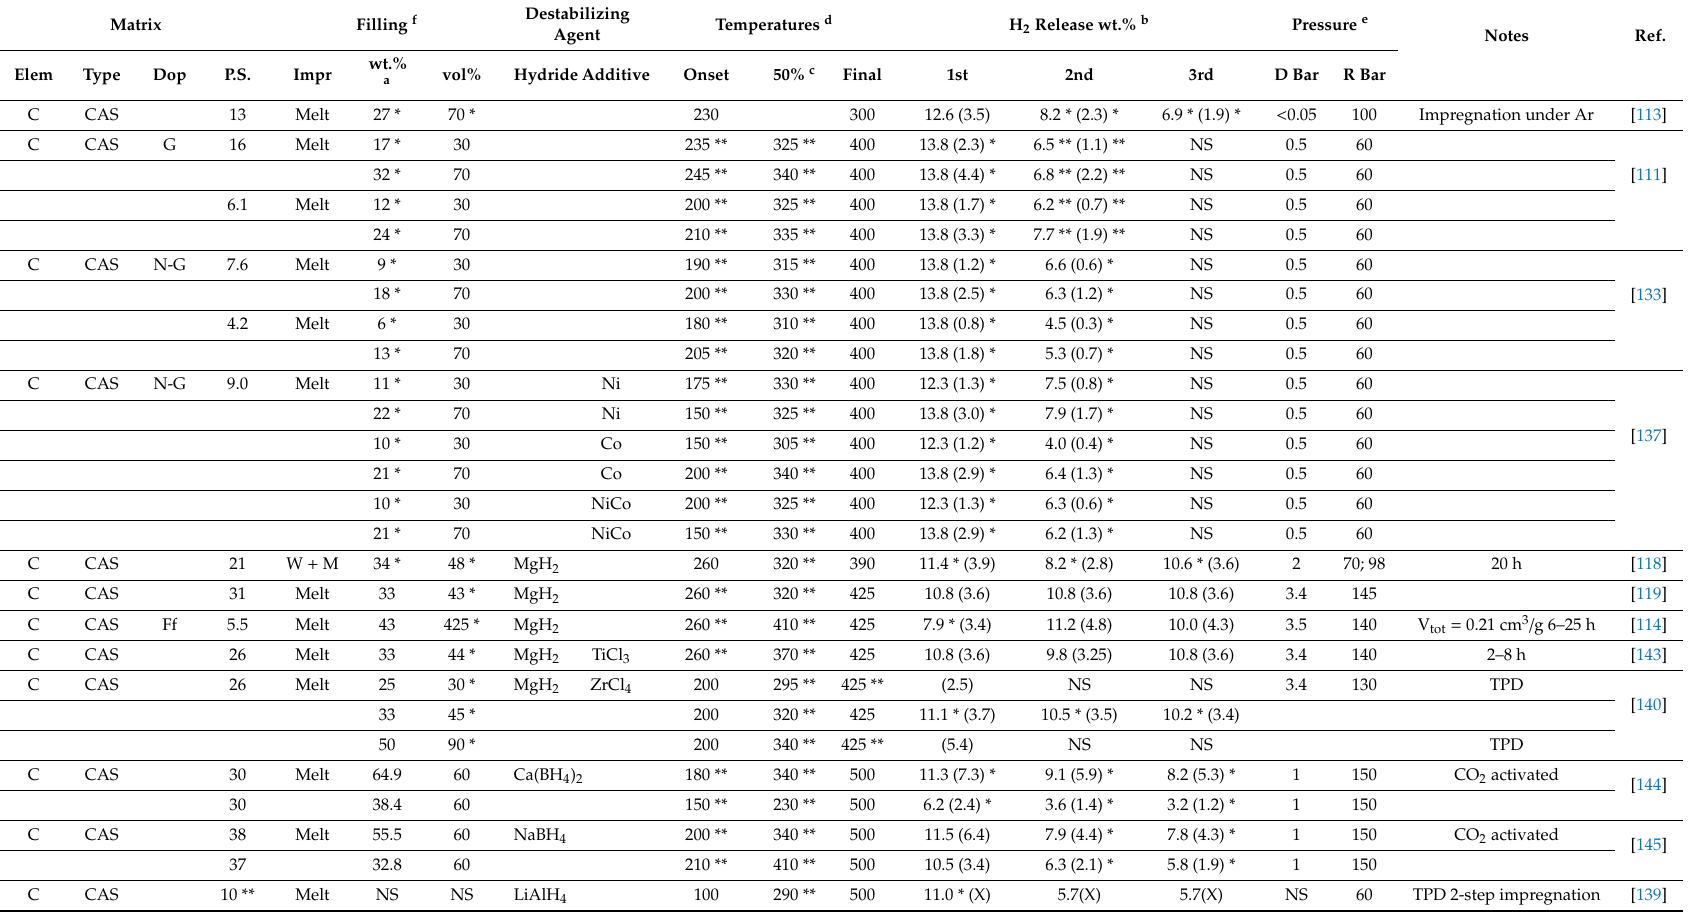
Table 9. Hydrogen storage properties of nanoconfined LiBH 4 -based composites in CAS